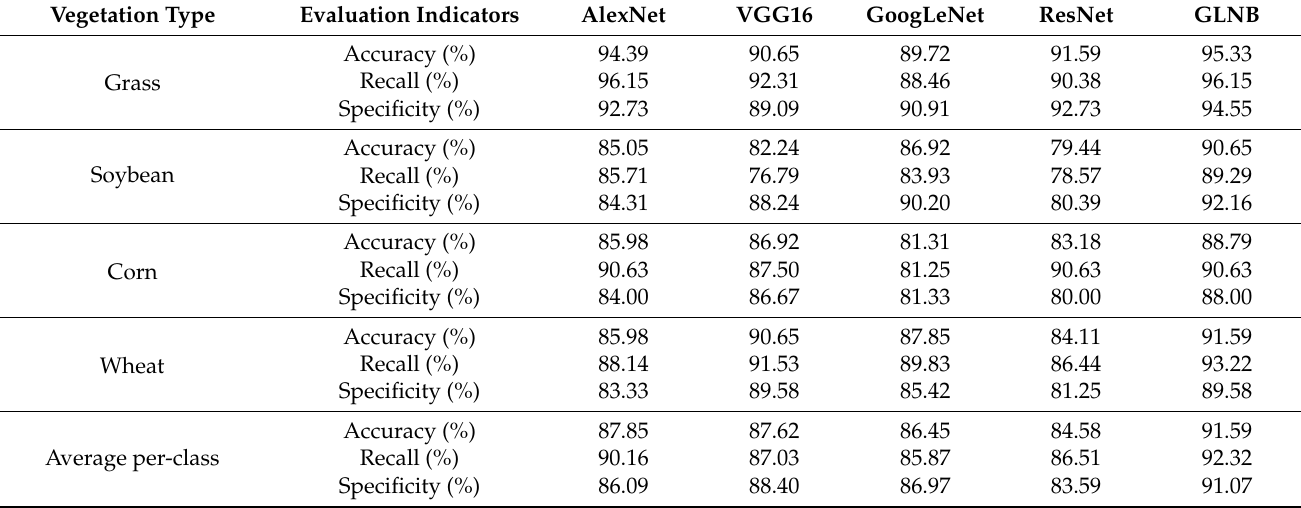
Table 2. Classification efficiency comparison among different CNN